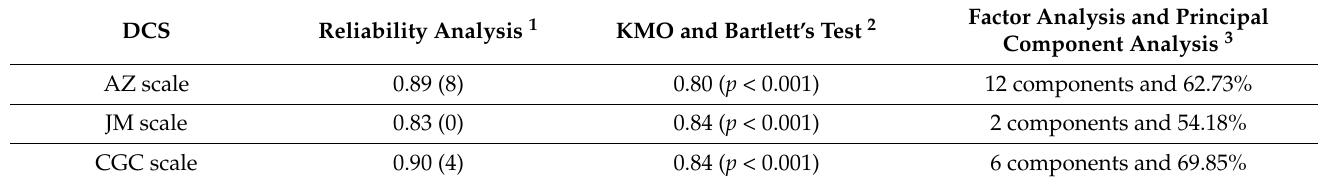
Table 4. Psychometric properties of the three digital citizenship scales